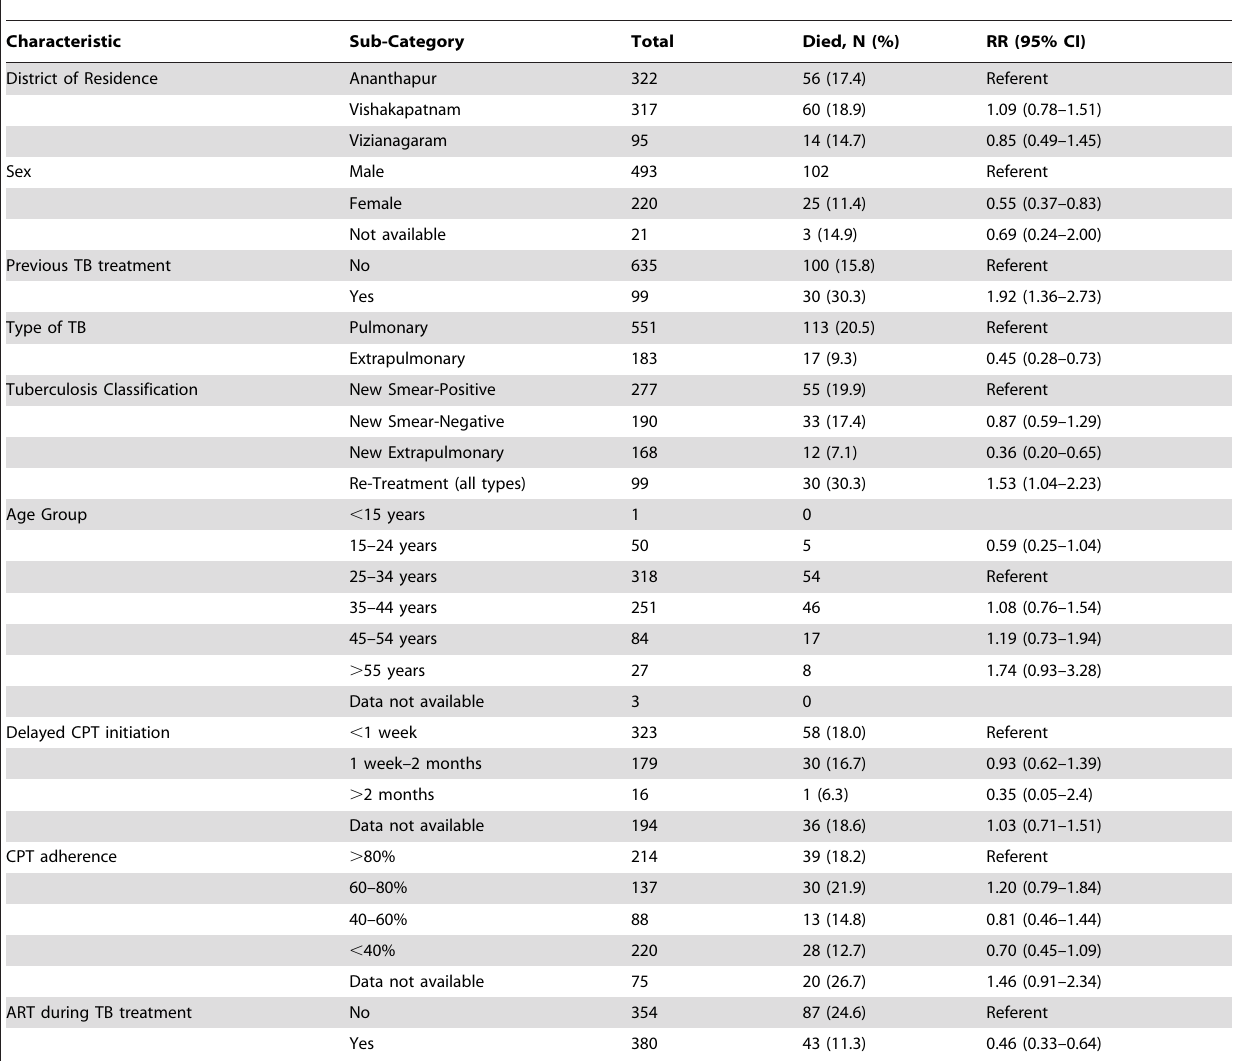
Table 4. Bivariate analysis of risk factors for mortality during TB treatment among HIV-infected TB patients, Andhra Pradesh 2007 (N=